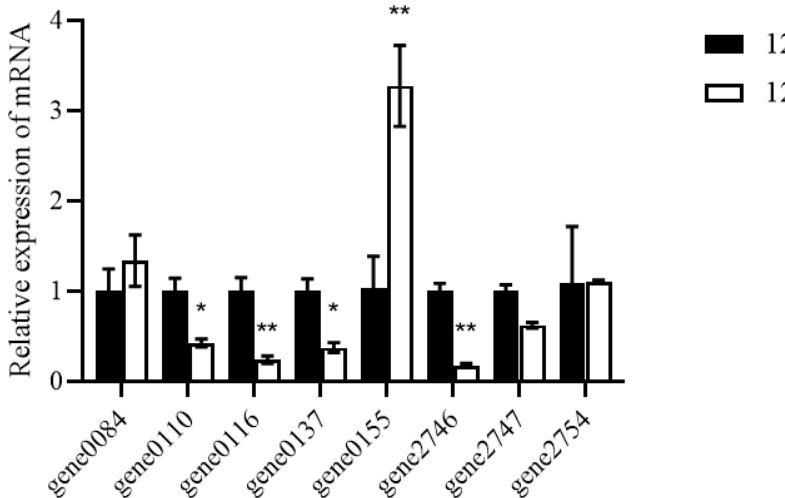
Figure 5. The transcript levels of alcohol metabolism related genes in L. pentosus LTJ12 cultured without or with ethanol. 12C stands for LTJ12 without ethanol, 12E stands for LTJ12 with 8% ethanol. The values represent the means of the three replicates with the standard deviation (SD). Asterisks represent significant differences from LTJ12 without ethanol. (statistical significance: * p < 0.05, ** p < 0.01).